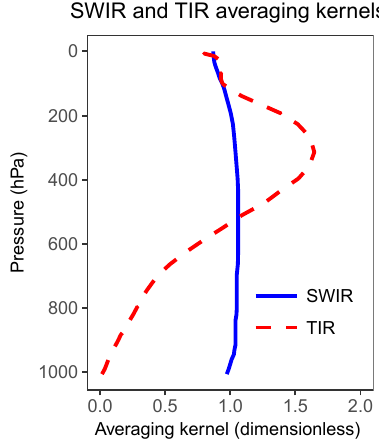
Figure 4. Typical vertical sensitivities (column averaging kernels) for satellite observations of atmospheric methane in the SWIR and in the TIR. Adapted from Worden et al.